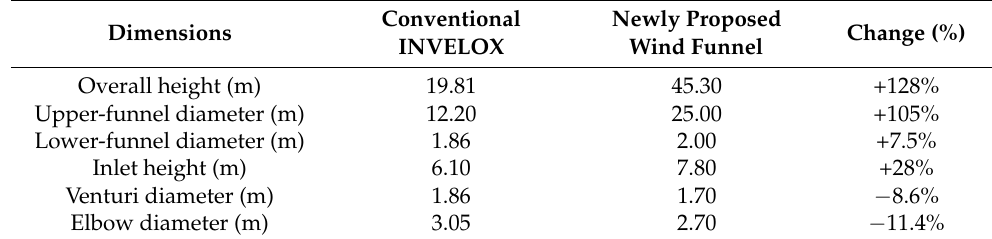
Table 1. Comparison of changes in dimension and design between conventional INVELOX and newly proposed omni-directional wind funnel. Conventional Newly Proposed Change (%) Dimensions INVELOX Wind Funnel Overall height (m) 19.81 45.30 +128% Upper-funnel diameter (m) 12.20 25.00 +105% Lower-funnel diameter (m) 1.86 2.00 +7.5% Inlet height (m) 6.10 7.80 +28% Venturi diameter (m) 1.86 1.70 − 8.6% Elbow diameter (m) 3.05 2.70 −